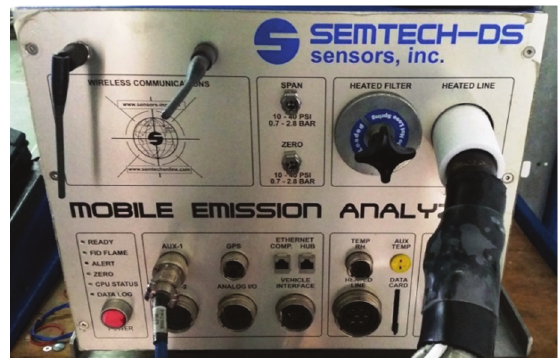
Fig. 3. The SEMTECH DS mobile analyzer used in the Ford Focus Flexi- fuel vehicle tests